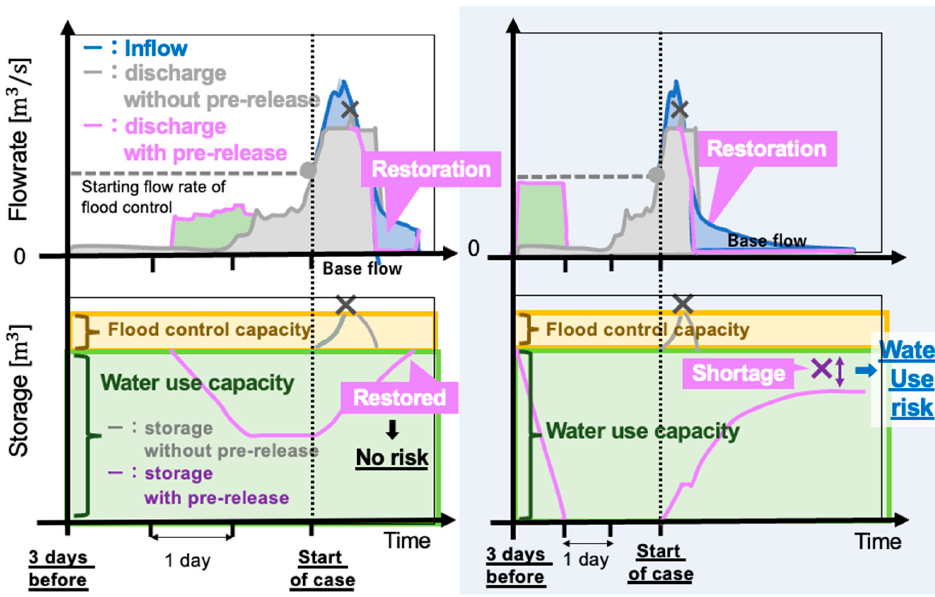
Figure 7. Pre-release simulation classi fi ed into no risk ( left ) and water use risk ( right